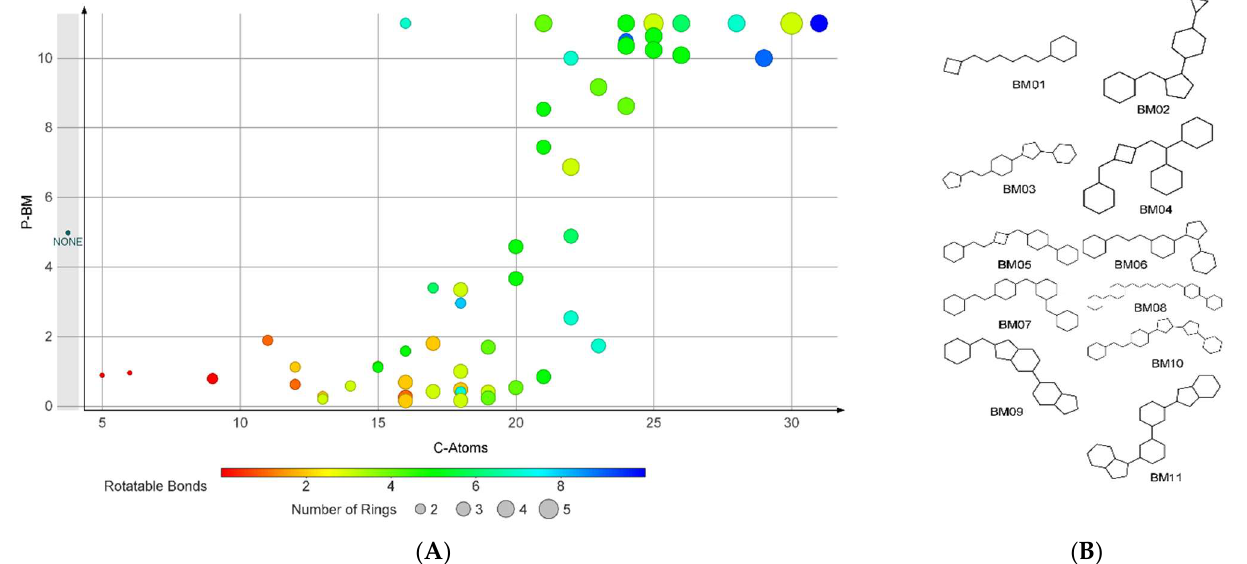
Figure 1. The analysis on BM skeletons: ( A ) The relation of P-BM value and number of carbon atoms, number of rings, and number of rotatable bonds for the BM skeletons with non-zero values; ( B ) the chemical structures of the BM skeletons generated by compounds found only in the FI set.